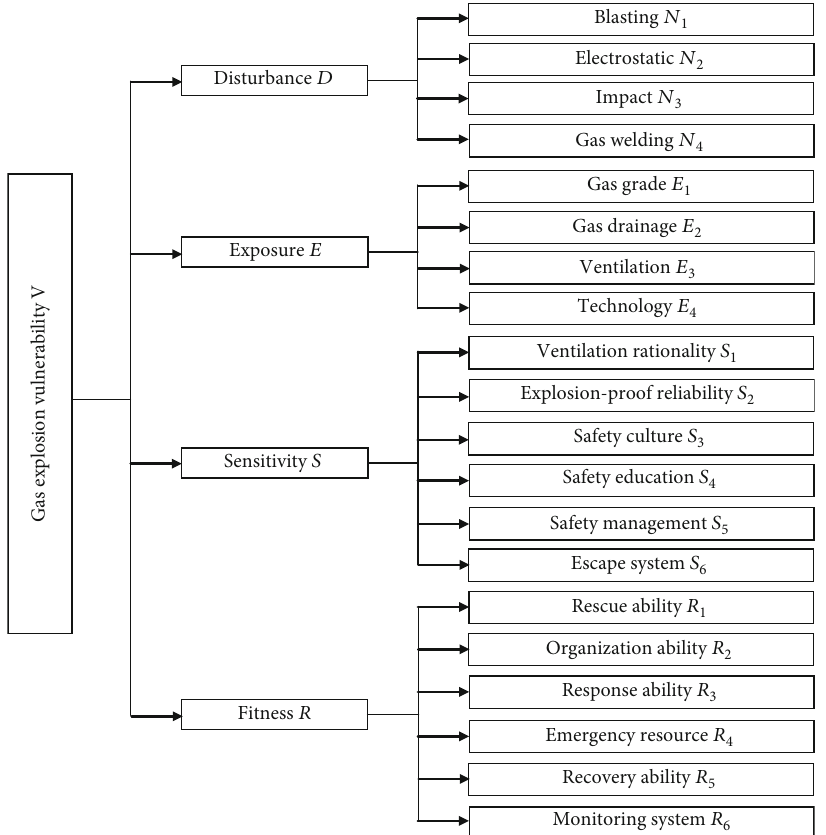
Figure 6: Gas explosion vulnerability assessment index